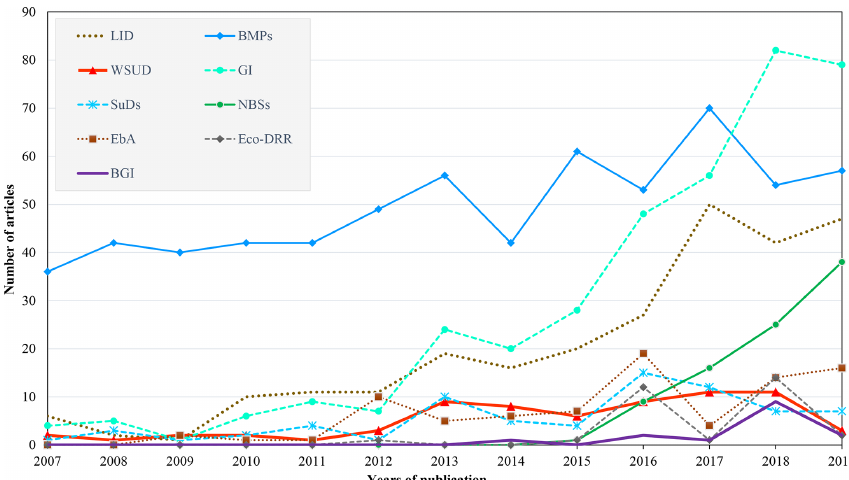
Figure 5. Number and trend of published articles on nature-based solutions (NBSs) for hydro-meteorological risk reduction and their sis- ter terms: low-impact developments (LIDs), best management practices (BMPs), water-sensitive urban design (WSUD), green infrastruc- ture (GI), sustainable urban drainage systems (SuDs), nature-based solutions (NBSs), ecosystem-based adaptation (EbA), ecosystem-based disaster risk reduction (Eco-DRR) and blue–green infrastructure (BGI).